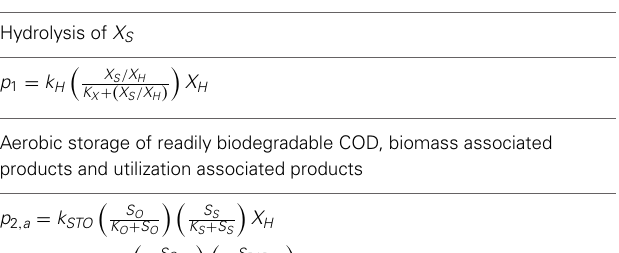
Table 2 | Mathematical expression of the model